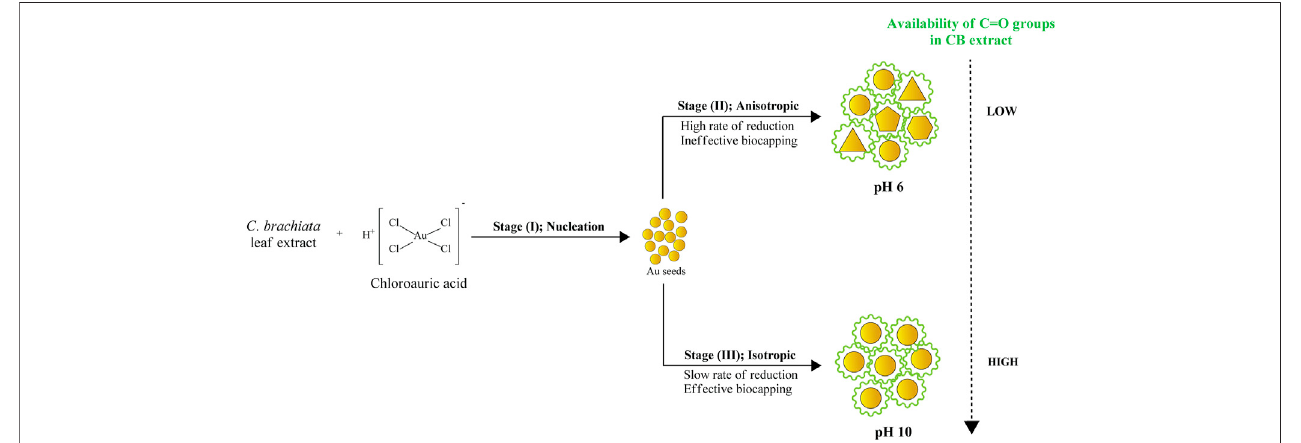
FIGURE 7 | Morphological changes in AuNPs as a function of pH.